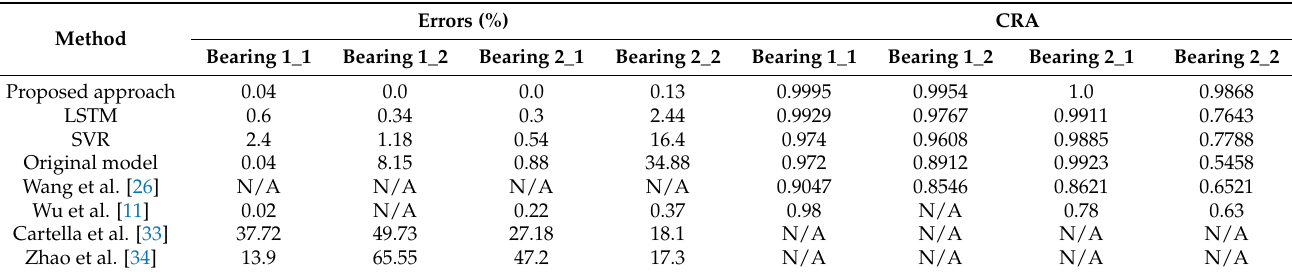
Table 2. Evaluation results of approaches considering two